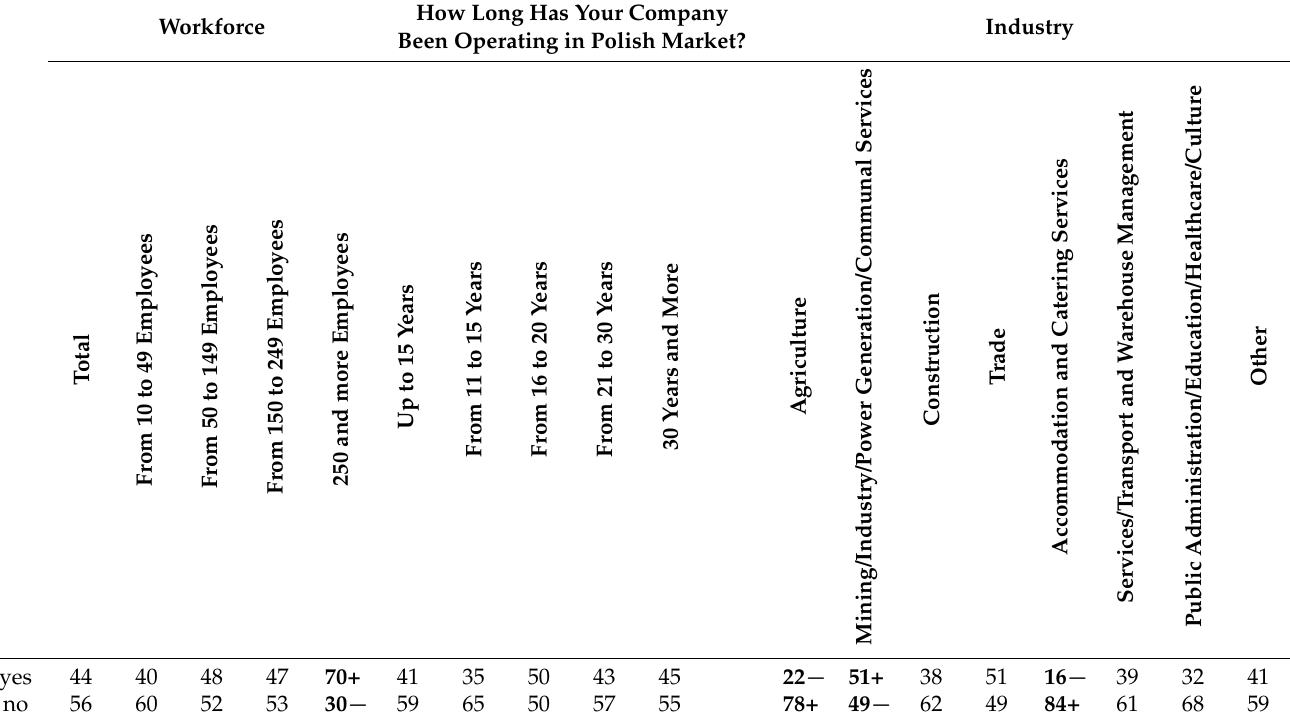
Table 5. Percentage of entrepreneurs investing or planning to invest in renewable energy—by workforce, period of operation and industry. Does the company undertake or plan any activities aimed at investing in renewable energy? How Long Has Your Company Workforce Been Operating in Polish Market?